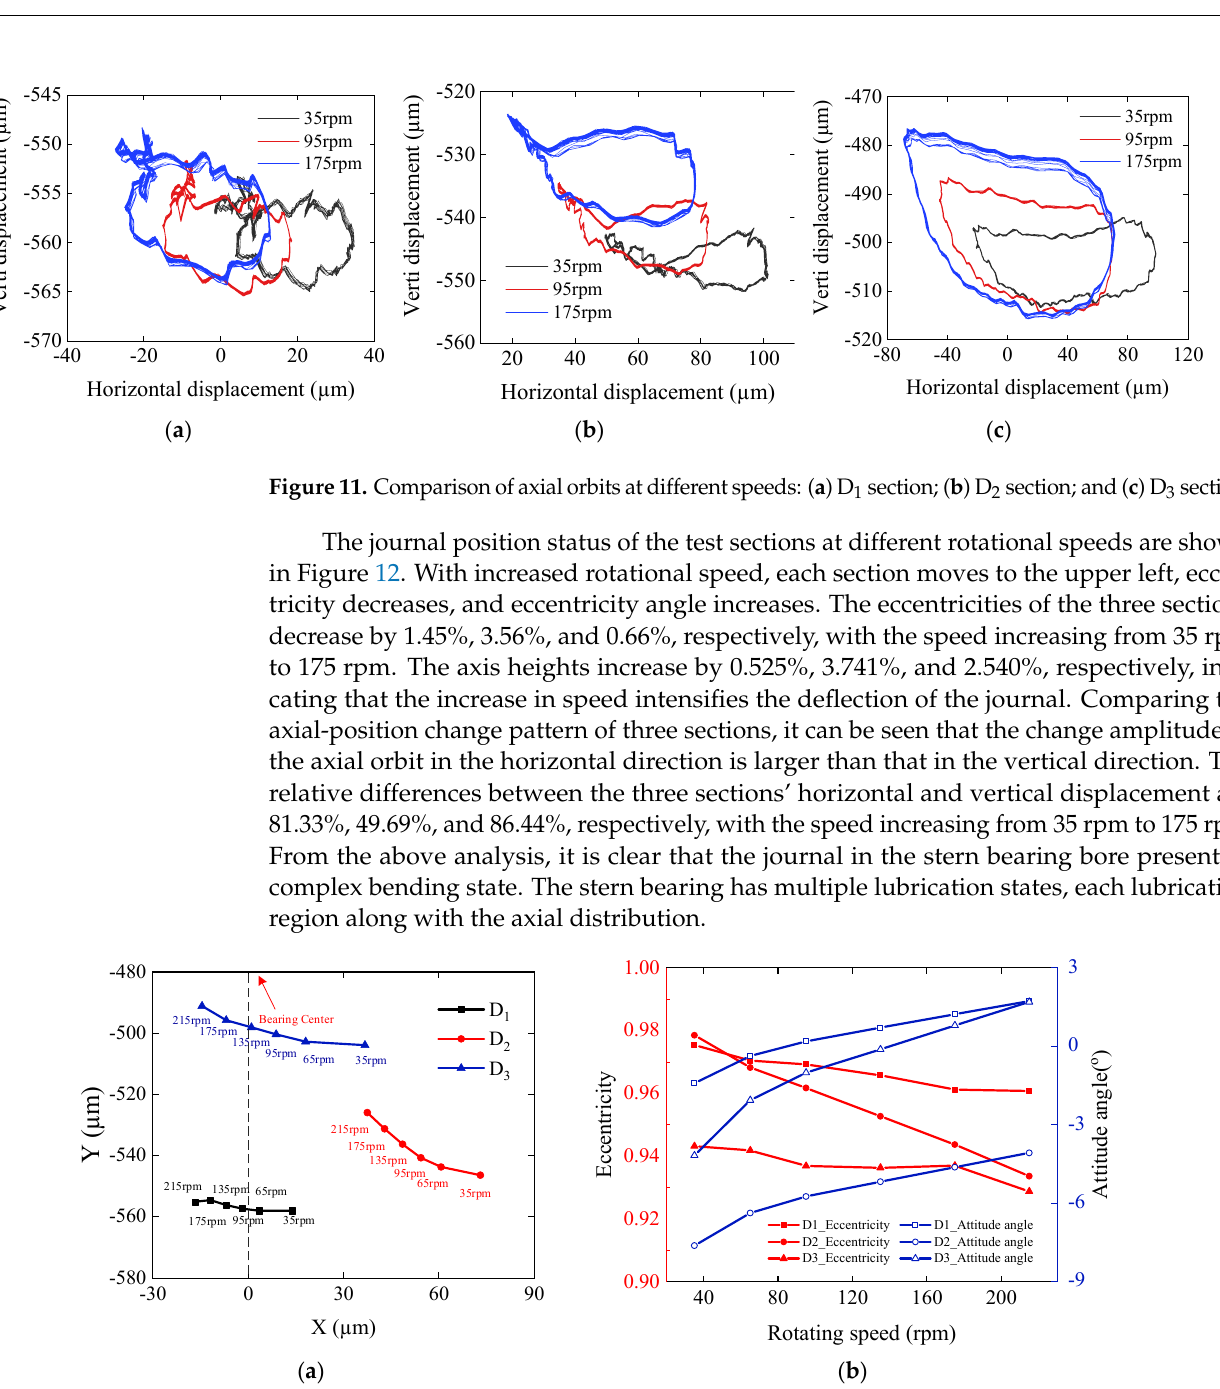
a complex bending state. The stern bearing has multiple lubrication states, each lubrica ‐ tion region along with the axial distribution.